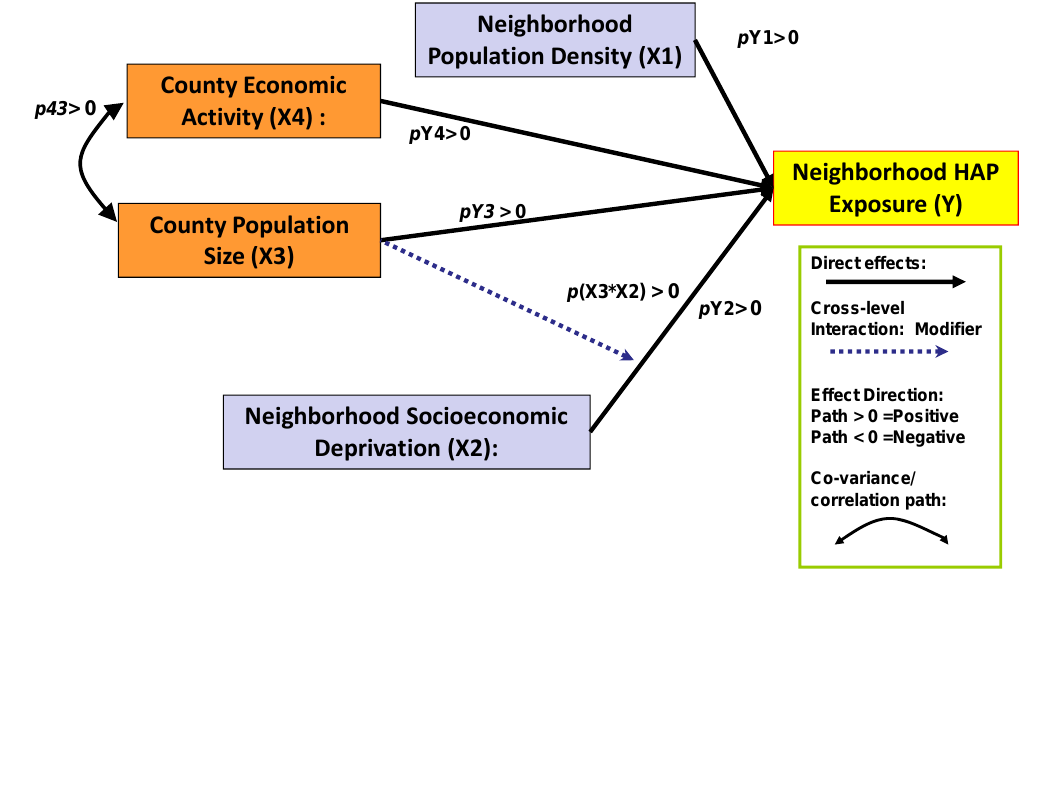
Figure 2. Multilevel HAP Exposure Model: County-Level Population Size as Effect Modifier of Tract-Level Socioeconomic Deprivation on HAP Exposure